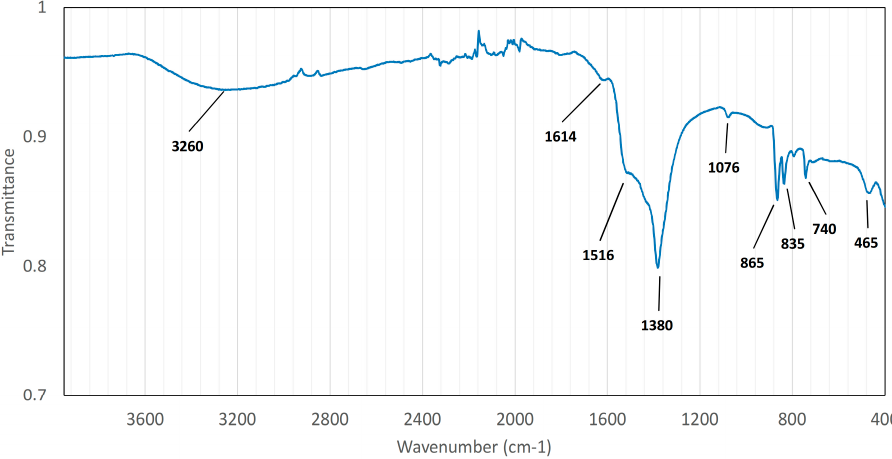
Figure 2. FTIR spectrum measured directly from the sample surface containing the nanowire